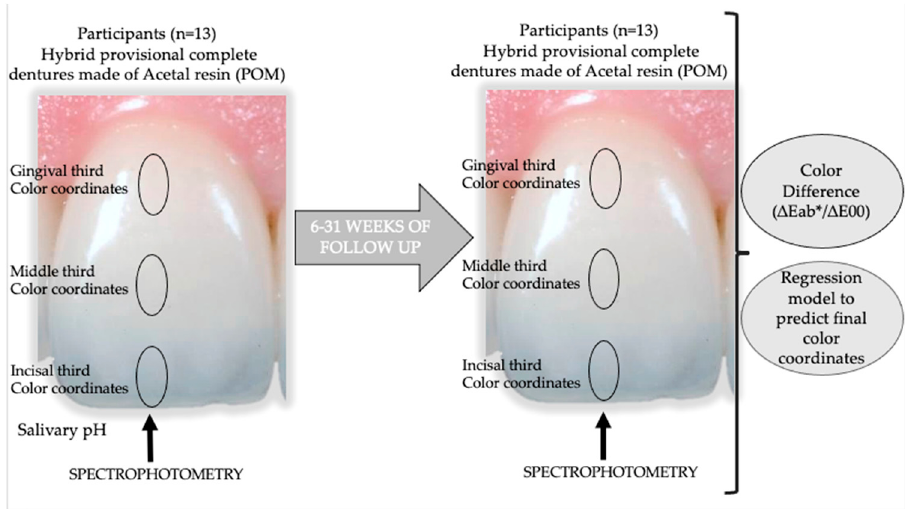
Figure 1. Scheme of the